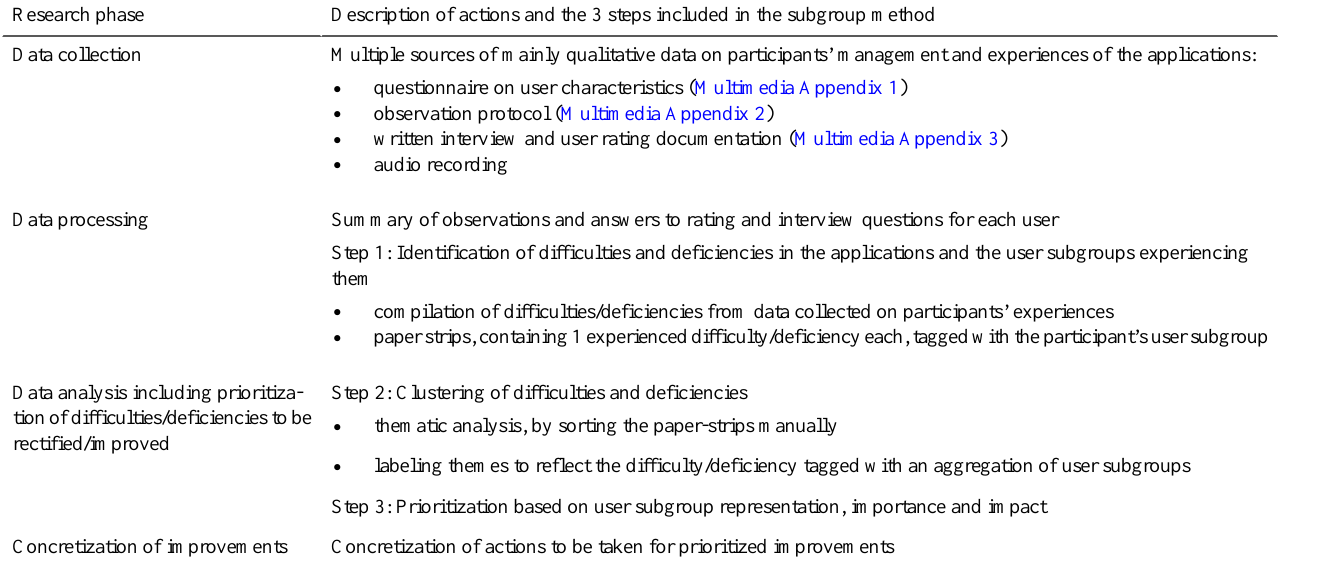
Table 1. Overview of the data collection, processing, and analysis, as well as the concretization of improvements in the usability testing, highlighting the 3 steps included in the subgroup